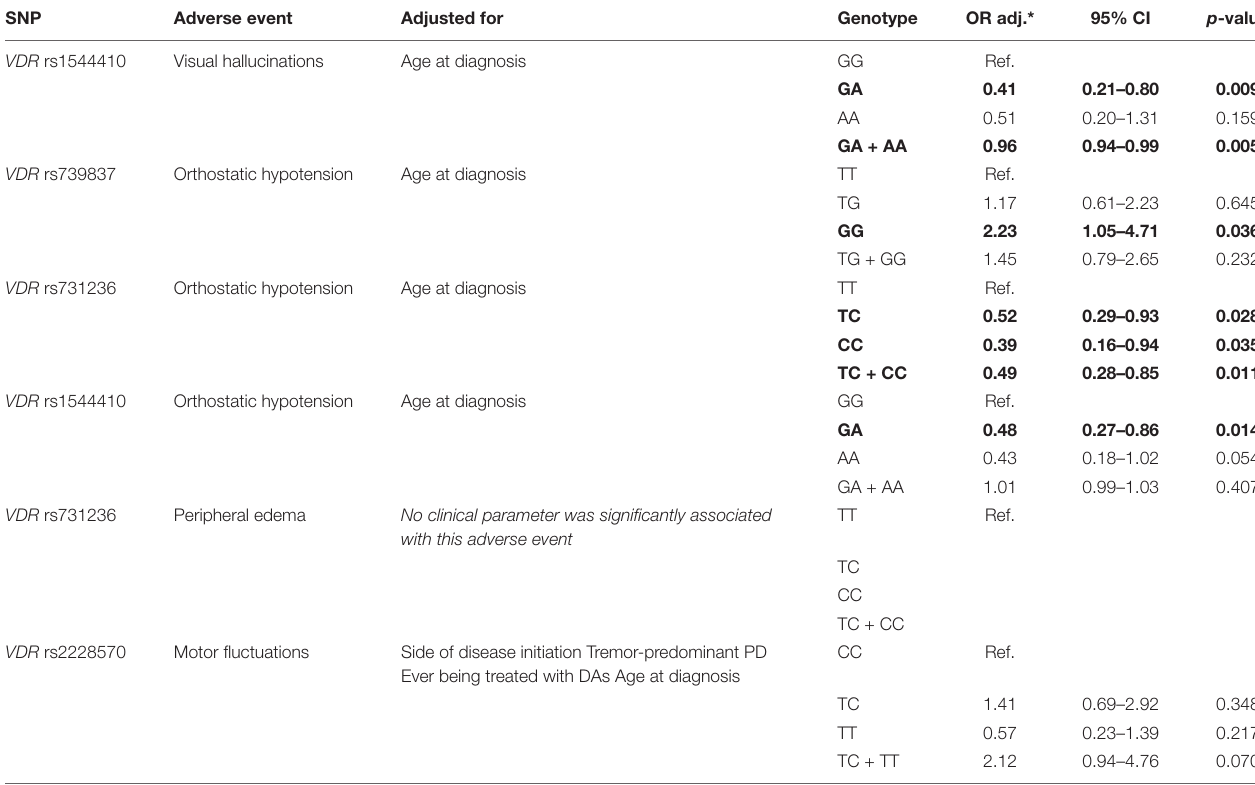
TABLE 4 | Significant associations from the univariate analysis adjusted for significant clinical parameters. SNP Adverse event Adjusted